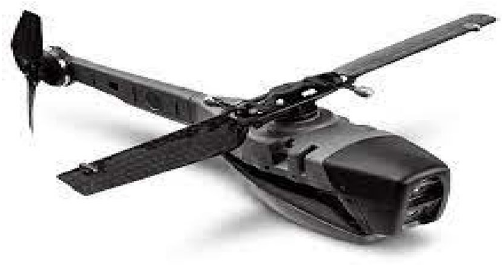
Figure 4. The Black Hornet micro UAV, it partially fits the needs of our project, but flight distance. Black Hornet measure is 0.168 cm, overall, and its weight is 0.033